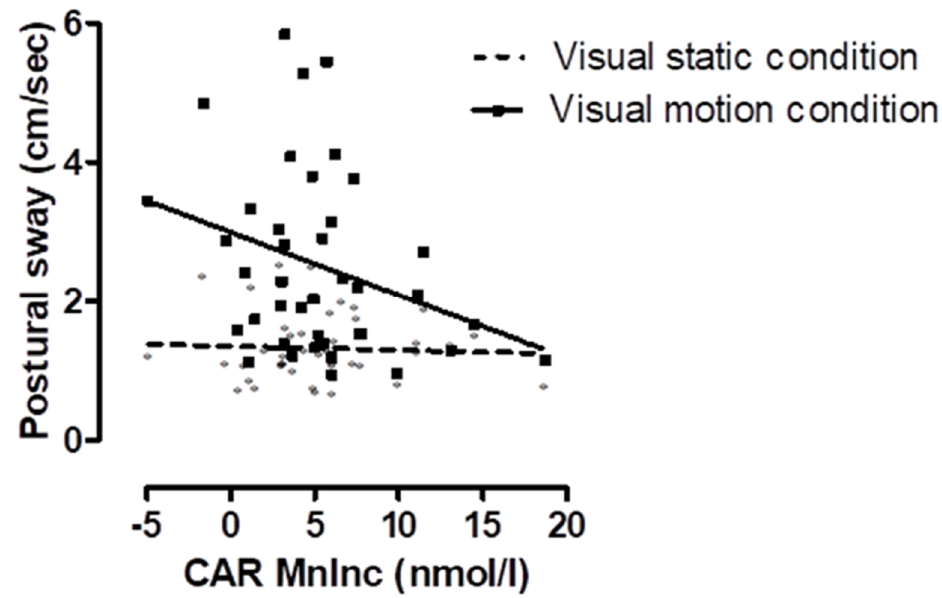
Figure 3. Interaction between standardised visual stimulus condition: static (grey diamond symbol) versus motion (black square symbol) and cortisol awakening response on postural sway (log cm/s).